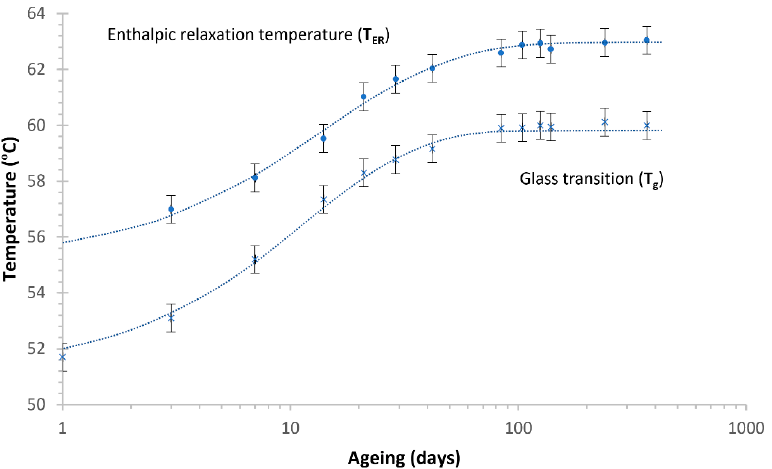
Figure 7. The glass transition and enthalpic relaxation temperatures at different ageing times with the corresponding KWW fitting equations (dashed lines).